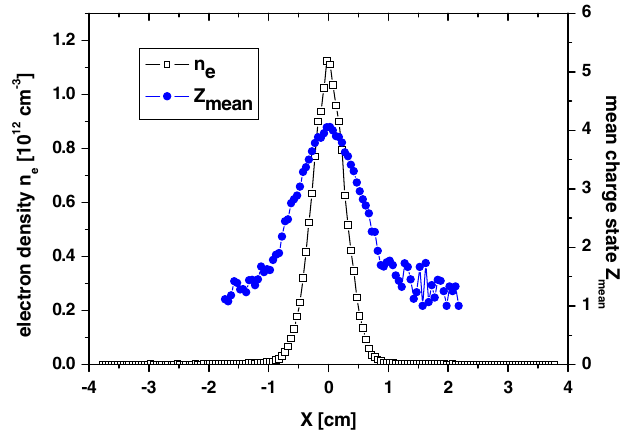
FIG. 4. (Color) Electron density (left scale) and mean ion charge state (right scale) at y ¼ 0 (between the star arms) as a function of x . The values are averaged in the z direction.